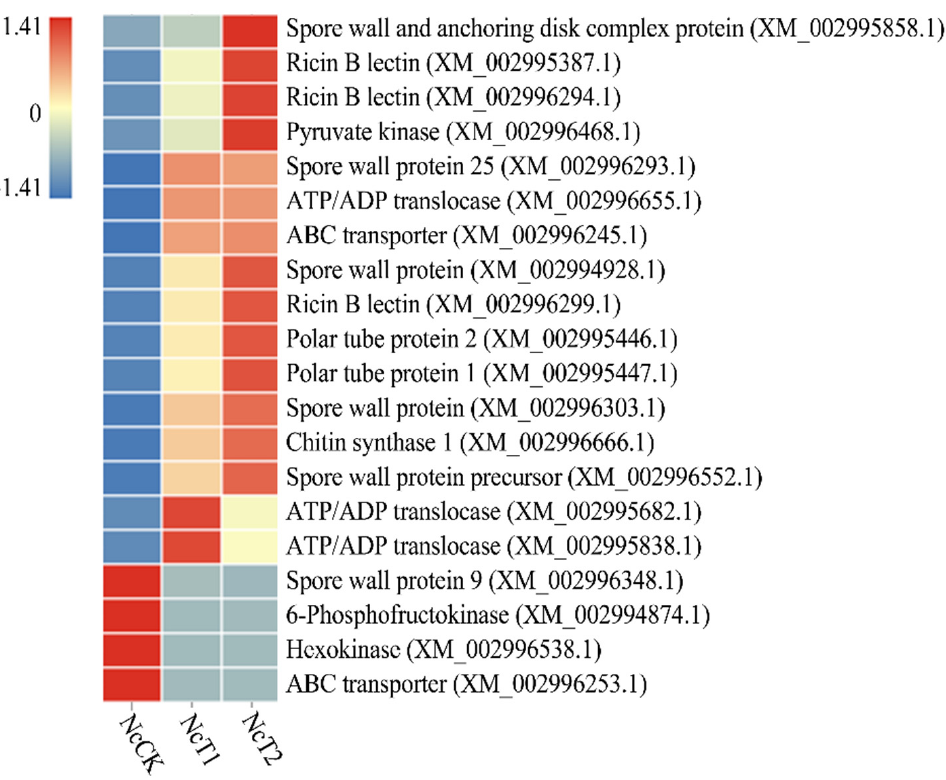
Figure 6. Heatmap of virulence factor-associated DEGs shared by the NcCK, NcT1, and NcT2